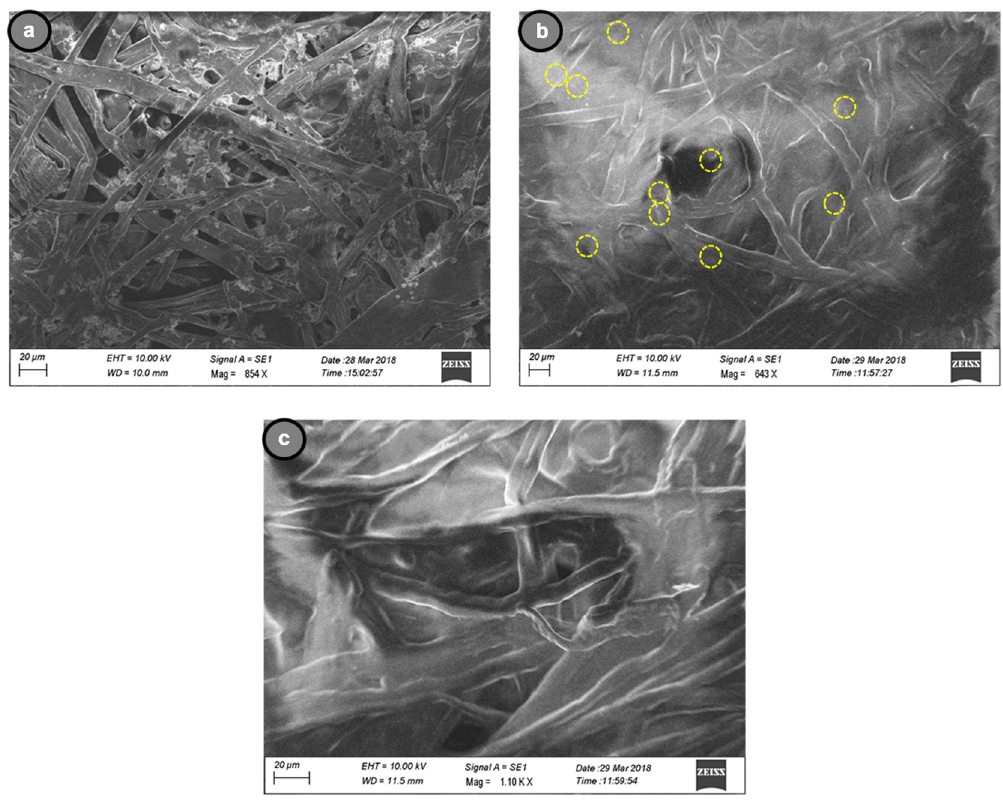
Figure 6: SEM images: ( a ) plain paper, ( b ) chitosan - coated paper, and ( c ) chitosan with agar - mediated AgNPs - coated